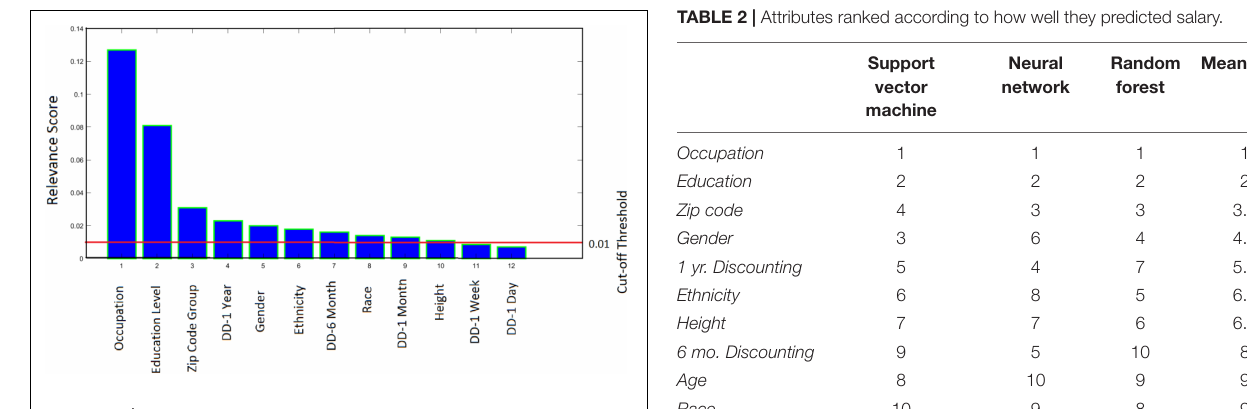
FIGURE 4 | The ReliefF algorithm gives a relevance score to each feature based on its quality in predicting the class to which data points belong. DD, delay discounting.